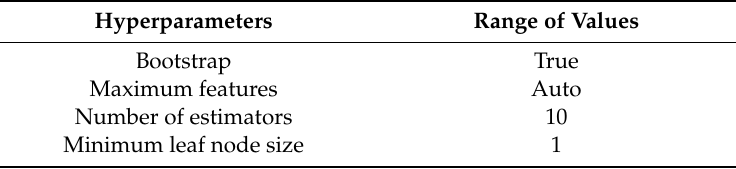
Table 3. Hyperparameters used for RF in the current study.